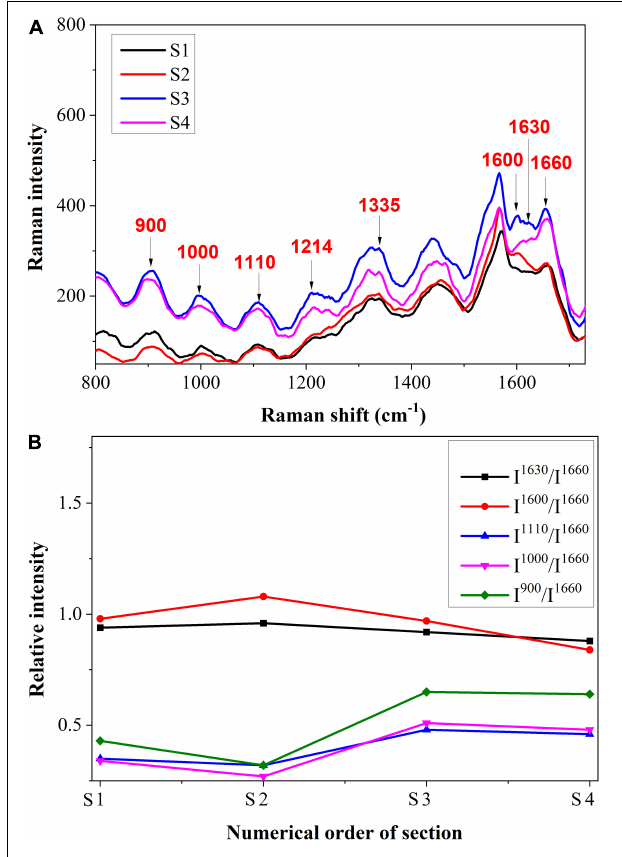
FIGURE 7 | (A) Raman spectroscopy and (B) Semi-quantitative intensity analysis of cell wall.